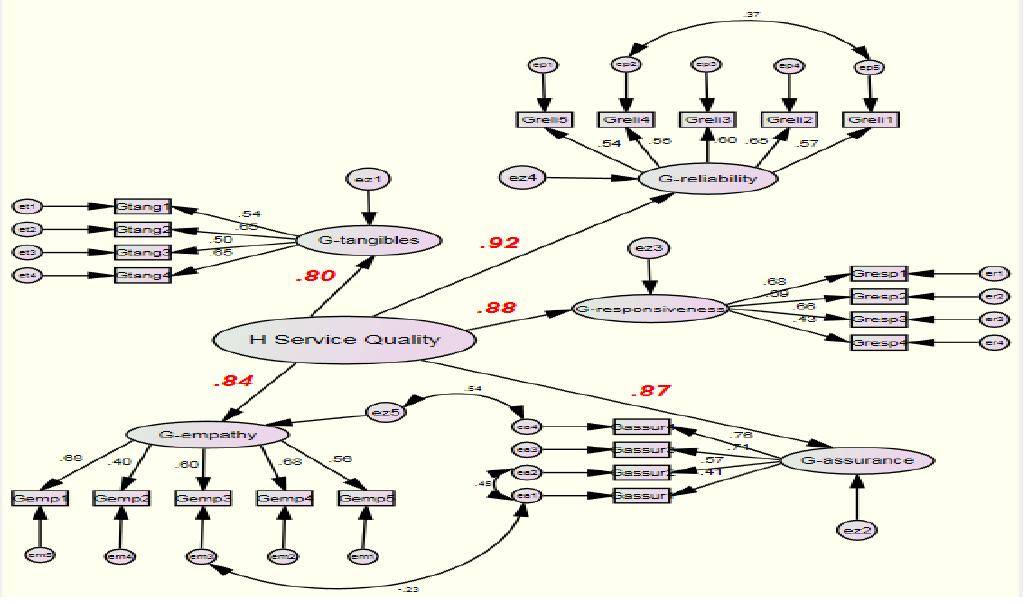
Fig. 3. The second-order conformity factor analysis (measurement model) For hospital service quality